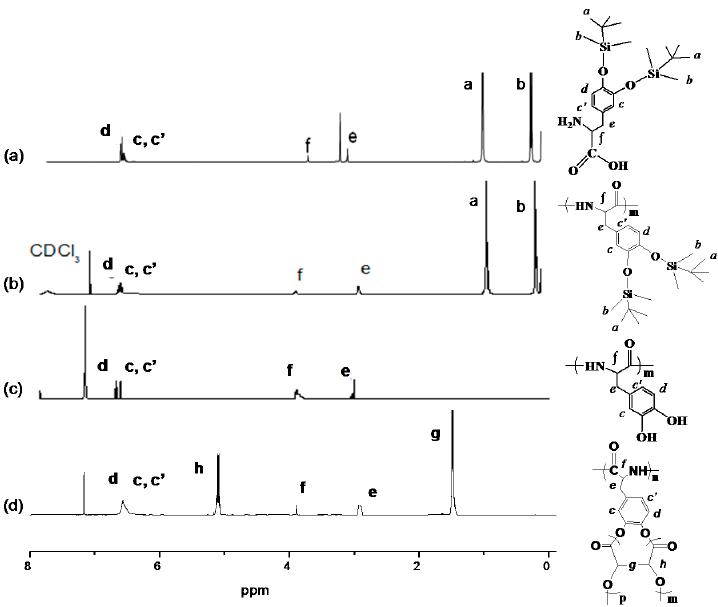
Figure 1. 1 H NMR spectra of DOPA(TBDMS) 2 ( a ); PDOPA(TBDMS) 2 ( b ); PDOPA ( c ); and PDOPA- g -PLA 20 ( d ).